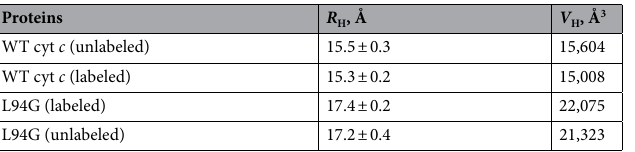
Table 2. Structural comparison of hydrodynamic properties between WT cyt c and its mutant L94G in the native buffer (pH 6.0) at 25°C a . a ± represents the error from the mean of errors of triplicate